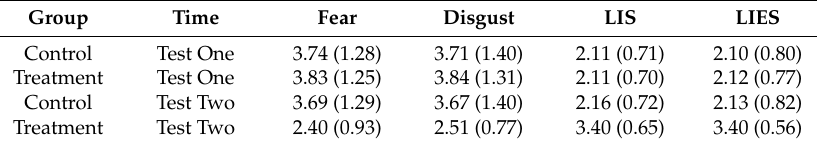
Table 1. Group and Time Means (Standard Deviations) for Fear, Disgust, Likelihood of Incorporating Information about Spiders into their Science Classroom (LIS) and Likelihood of Incorporating Information about the Ecological Services of Spiders into their Science Classroom (LIES)